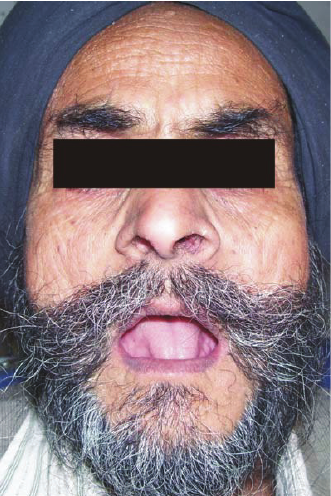
Figure 1: Preoperative photograph.